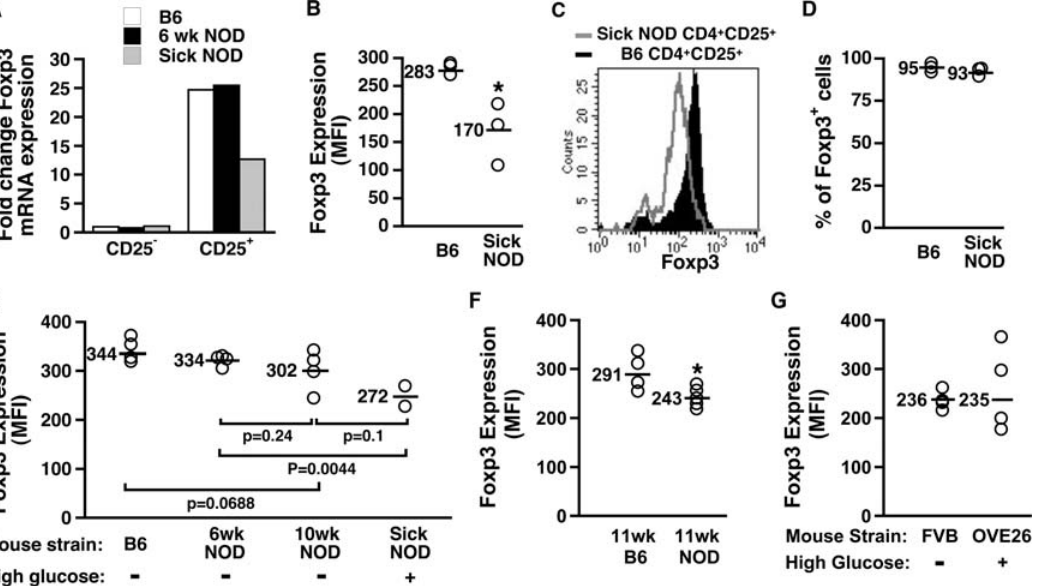
Figure 1. Foxp3 expression is decreased in CD4 + CD25 + cells from NOD mice. Cells from lymphoid organs were harvested from 6-week-old NOD, or 15–20 week-old B6 and Sick NOD mice and pooled. CD4 + CD25 2 and CD4 + CD25 + cells were sorted ( . 95% purity), and mRNA was isolated and real-time PCR performed using Foxp3 and GAPDH primers (A). Cells from lymphoid organs were harvested from 15–20 week-old B6 and Sick NOD mice (B–D); or 6 and 10-week-old NOD and B6 mice or 15–20 week-old Sick NOD mice (E); or 11 week-old B6 and NOD mice (F); or 8 week-old FVB wild-type (control) and OVE26 transgenic mice (G). Samples from individual mice were labeled with anti-CD4, CD25 and Foxp3 antibodies, and CD4 + CD25 + cells were gated and analyzed for Foxp3 expression (% and MFI) by FACS H (B–G). Each point represents an individual animal. Blood glucose levels were evaluated weekly beginning at 12 weeks of age, and mice were considered diabetic (Sick) when glucose levels reached 300 dl/ml and were maintained for at least two consecutive weeks. An * indicates a significant difference from B6 controls at p , 0.05.